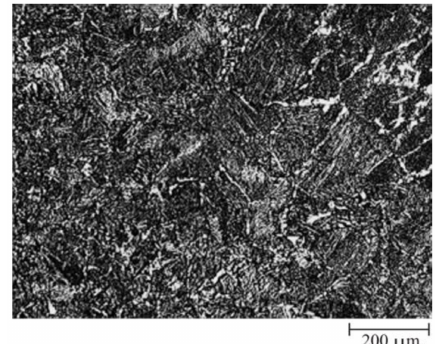
Figure 18. Dendritic structure of weld, etch. Nital.